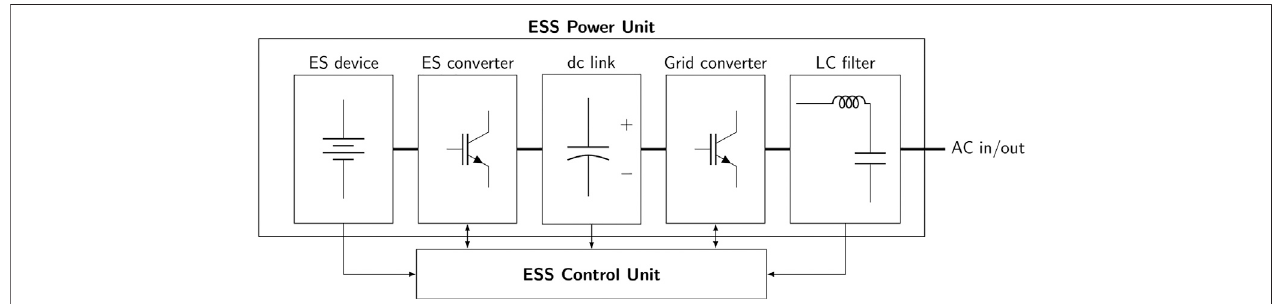
FIGURE 3 | Elements of a converter-interfaced energy storage